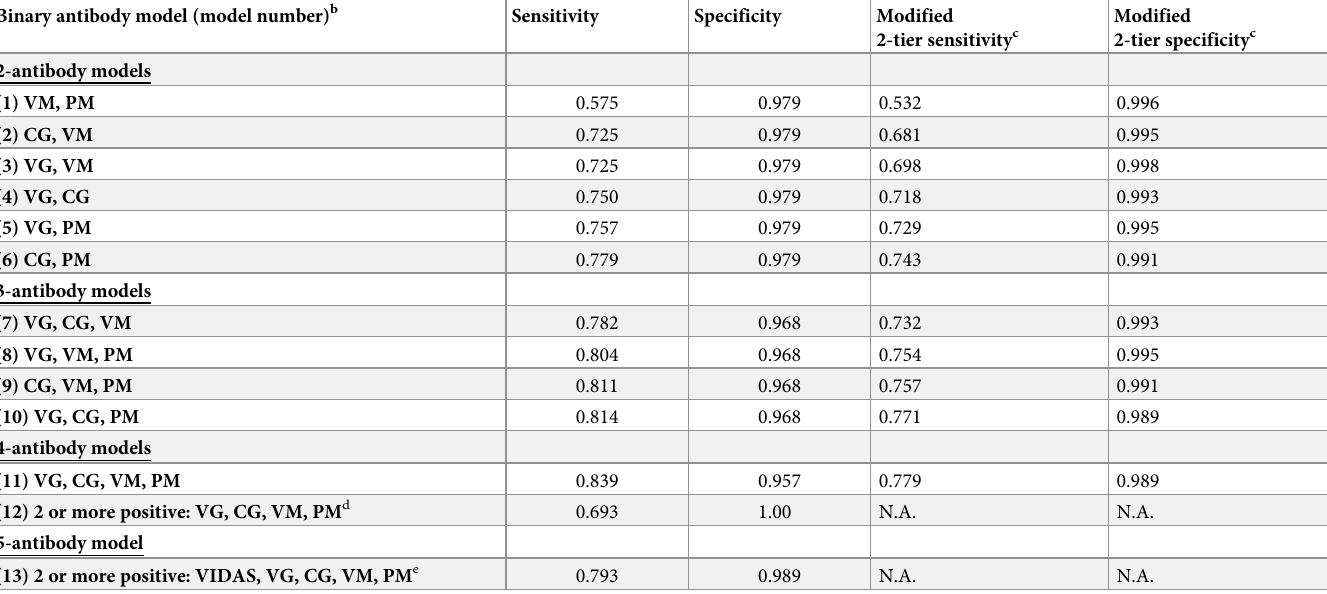
Table 2. Sensitivity and specificity of binary models constructed using Boolean “OR” logic a . Binary antibody model (model number)